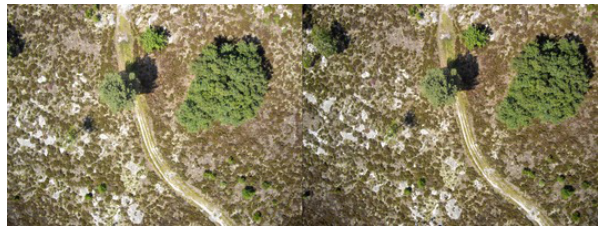
Figure 11: Stereo couple